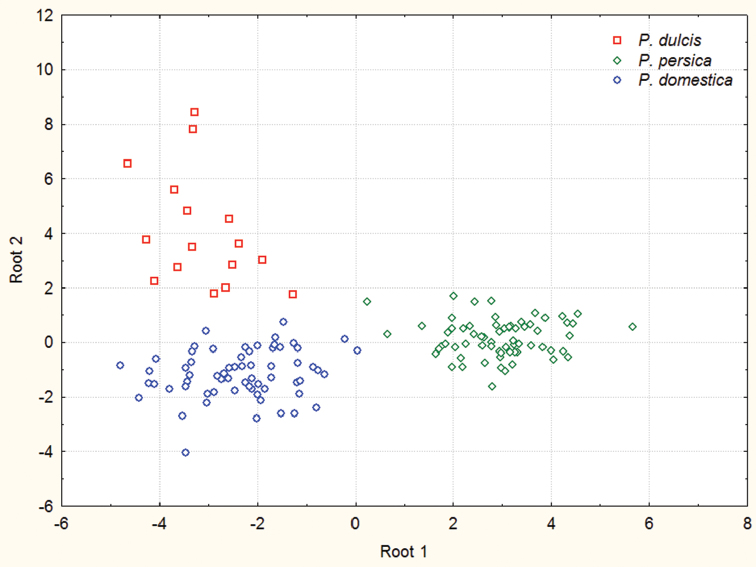
Scatter-plot of the individual canonical scores of the first two canonical variates discriminating 21 samples of Hyalopterus collected from different host plants in five European countries (Bulgaria, Hungary, Lithuania, Romania, Slovakia).